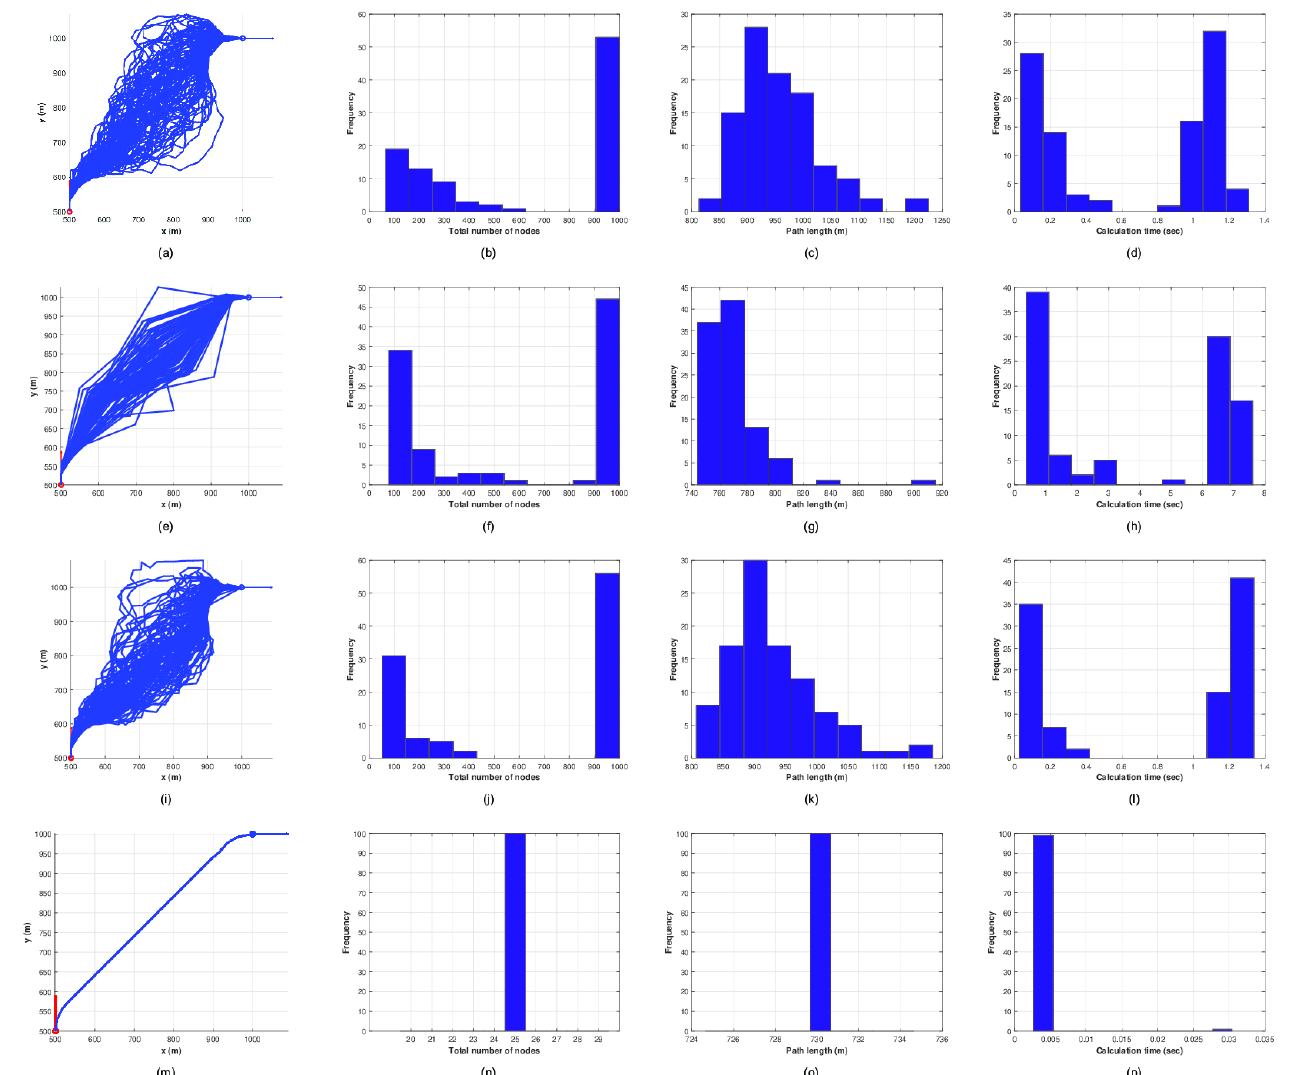
Figure 9. Results of no obstacles: ( a – d ) RRT. ( e – h ) RRT*. ( i – l ) Biased RRT. ( m – p ) Dubins